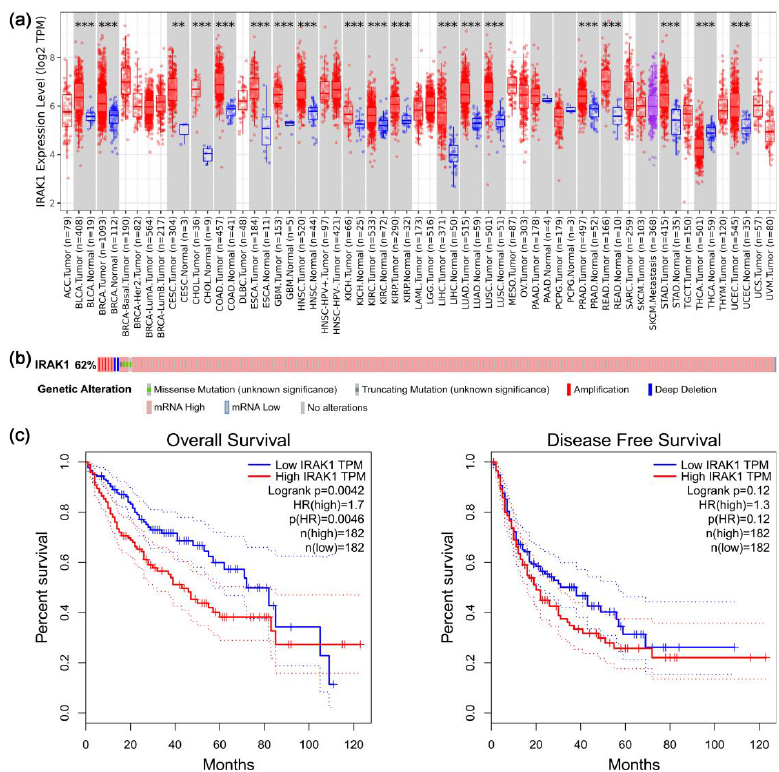
Figure 1. Pan-cancer, gene alteration, and survival analyses regarding interleukin-1 receptor-associated kinase 1 (IRAK1). ( a ) Pan-cancer analysis of IRAK1 expression. Comparisons between tumors and adjacent normal tissues are displayed in gray columns. The statistical significance is annotated as ** ( p < 0.01), and *** ( p < 0.001); ( b ) onco-print diagram for alterations of IRAK1 in hepa- tocellular carcinoma. The judgement of mRNA-high or -low was based on the expression z -scores calculated relative to normal samples and the set threshold ( ± 2.0); ( c ) effects of IRAK1 expression on overall survival and disease-free survival of patients with hepatocellular carcinoma. The group cutoff was set at median, and, therefore, the high expression (samples with expression levels higher than this threshold) and low expression (samples with expression levels lower than this threshold) groups each accounted for 50% of the total LIHC